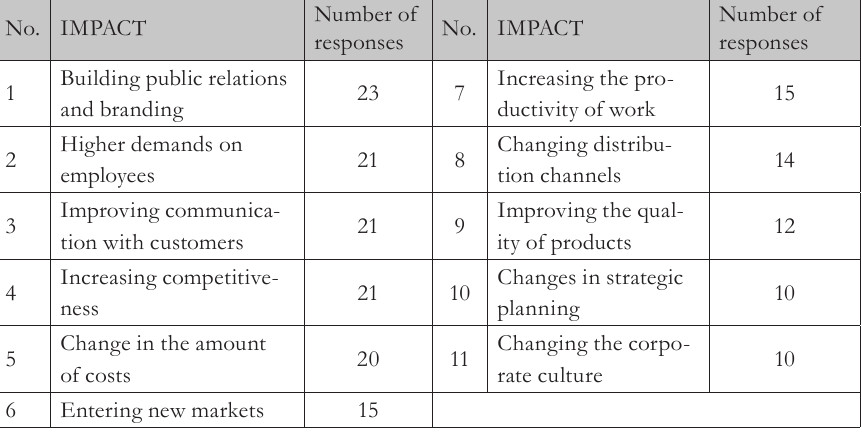
Tab. 2 - Impacts associated with the implementation of marketing innovation in